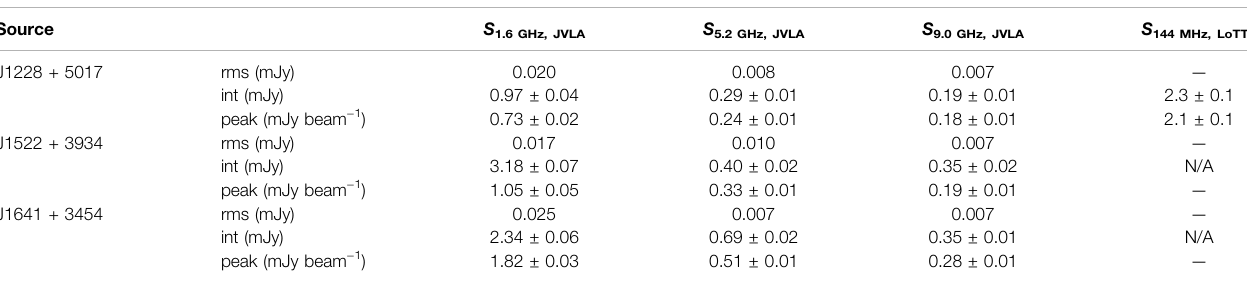
TABLE 2 | Summary of the radio fl ux densities of the sources. Source